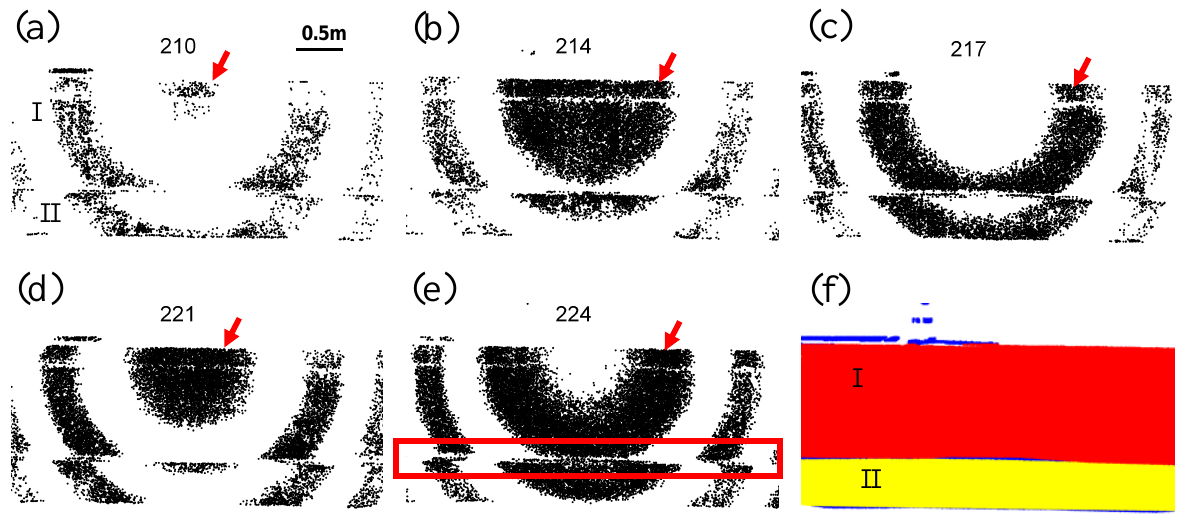
image of 210, 214, 217, 221, and 224, excerpted from the intensity image sequence in Supplementary Material 2, which contains the grey intensity from 187 to 255. The red rectangle denotes the linear discontinuity feature between the concentric circular patterns of surface I and II. See the text in Section 3.3 for the explanation of the red arrows. (f) Segmentation result using the visual cues of two distinct concentric circular patterns and a linear feature [denoted by the red rectangle in (a)] in the intensity image sequence in Supplementary Material 2. Red and yellow denote surfaces I and II, respectively, while blue represents the un-segmented 3D laser